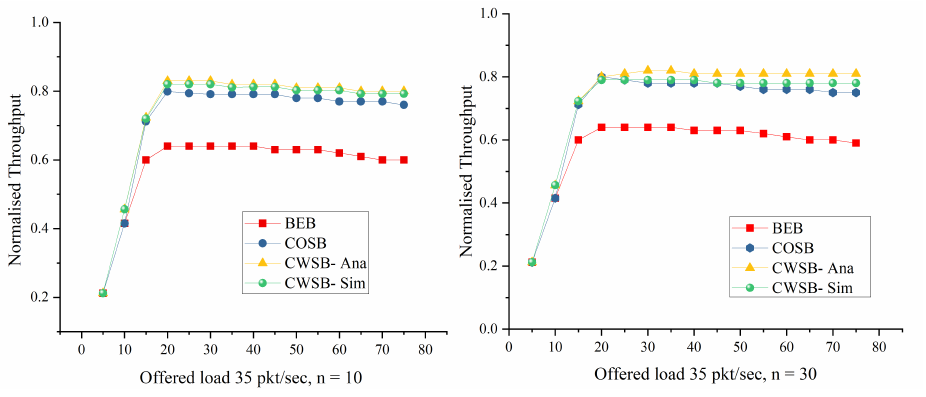
Figure 11. Normalised throughput under an unsaturated traffic